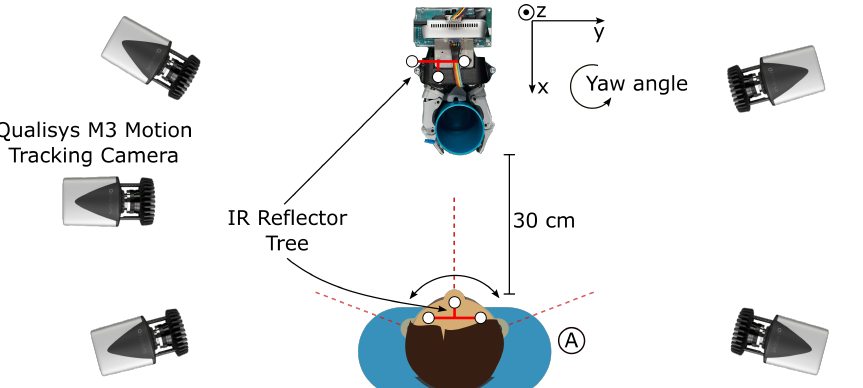
Figure 9. Test setup to measure the required angle to trigger the abort command. The red dashed lines represent the heading direction.